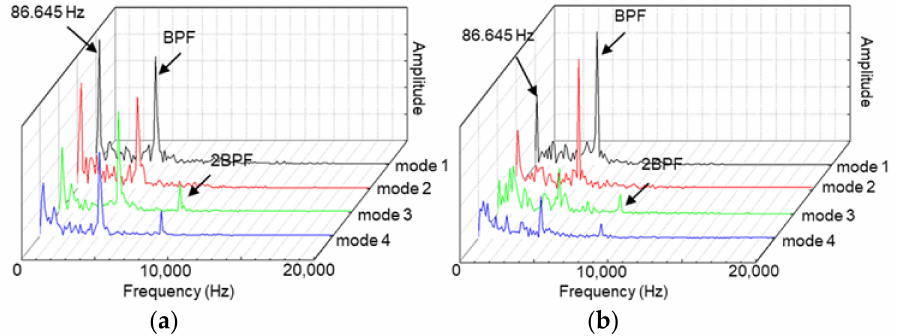
Figure 20. Spectrum results of POD eigenvectors: ( a ) TVD; ( b )